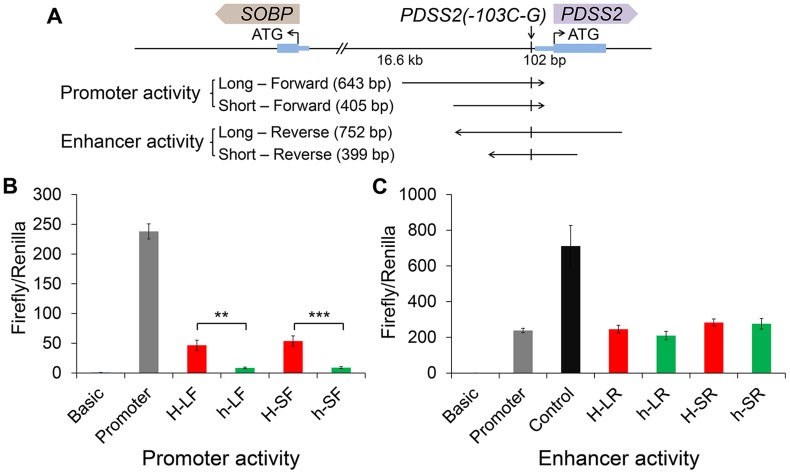
Effects of the silky-feather mutation on promoter and enhancer activity using a luciferase reporter assay.(A) Schematic description of vectors used for luciferase reporter assay. Long and short sequences for each allele are used for vector construct separately. The wild-type (H) or silky-feather (h) allele forward sequence is inserted to the empty vector pGL3-Basic. The wild-type (H) or silky-feather (h) allele reverse sequence is also inserted to the empty vector pGL3-Promoter. (B) Promoter activity and (C) Enhancer activity analyses in chicken DF1 cell are shown for each vector. The pGL3-Basic, pGL3-Promoter and pGL3-Control vectors are used as control. Three technical repeats are performed for each vector in one experiment. Firefly in relation to Renilla luciferase levels is calculated with the empty vector pGL3-Basic as reference. The average value of three technical repeats is represented as one activity value. Three separate repeats are performed and used to calculate mean and standard deviation (SD). The activity associated with the wild-type (H) and silky-feather (h) constructs are compared using a Student's t-test. ** indicates P<0.01 and *** indicates P<0.001.